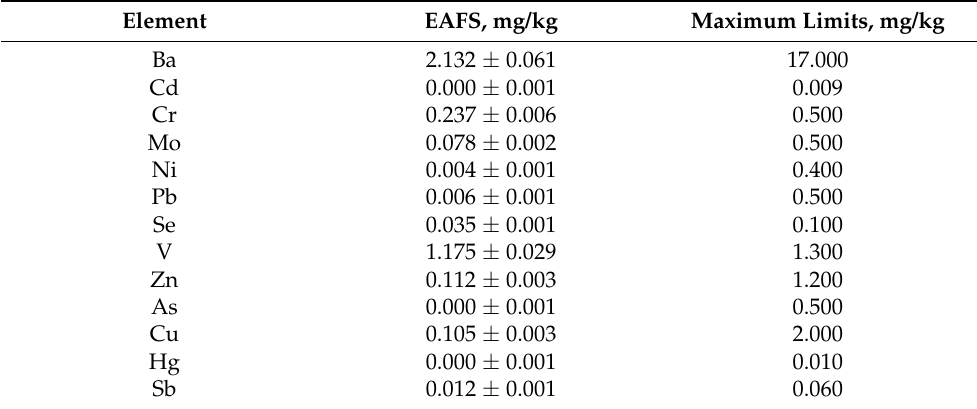
Table 5. Concentration of chemical elements in the leaching of the electric arc furnace